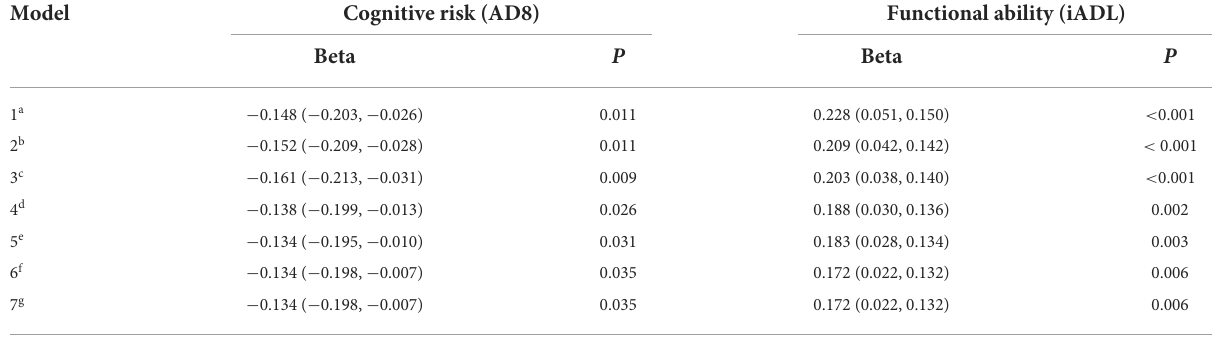
TABLE 3 Univariable and multivariable linear regression coefficients (and 95% CI) expressing independent associations between adherence to a Mediterranean diet, functional ability (iADL), and cognitive risk (AD8).